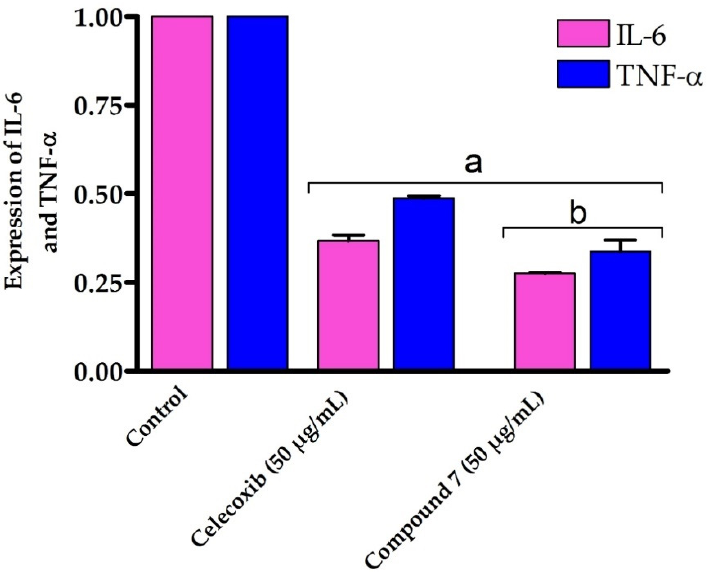
Figure 7. In vitro anti-inflammatory effect of compound 7 against LPS-activated RAW264.7 cell line on IL-6 and TNF- α expression. Data are shown as mean ± SD. a p < 0.05 versus control cells and b p < 0.05 versus celecoxib.